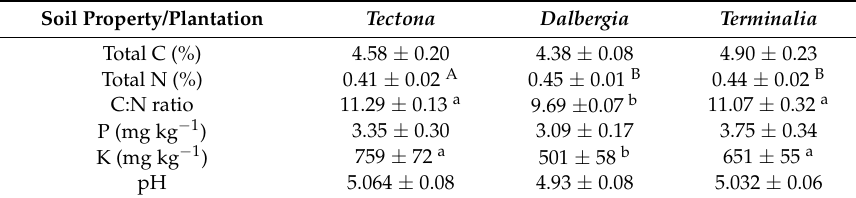
Figure 2. Principal component analysis of soil properties (C, N, P, K and pH) measured in each of five blocks in three monoculture plantations: Tectona grandis (blue circles), Dalbergia retusa (red triangles) and Terminalia amazonia (yellow diamonds) at the start of a mesocosm experiment in Panama, Central America. Table 1. Initial soil properties in three monoculture plantations used in a litter decomposition experiment in Panama, Central America, showing total soil carbon (C), total soil nitrogen (N) and carbon to nitrogen (C:N) ratios, extractable phosphorus (P), and potassium (K) concentrations, and soil pH. Means ± standard errors are shown for n = 5 composite soil samples; different lower-case superscript letters indicate significant differences among plantations at p < 0.05 and different upper-case superscript letters indicate trends at p < 0.1.